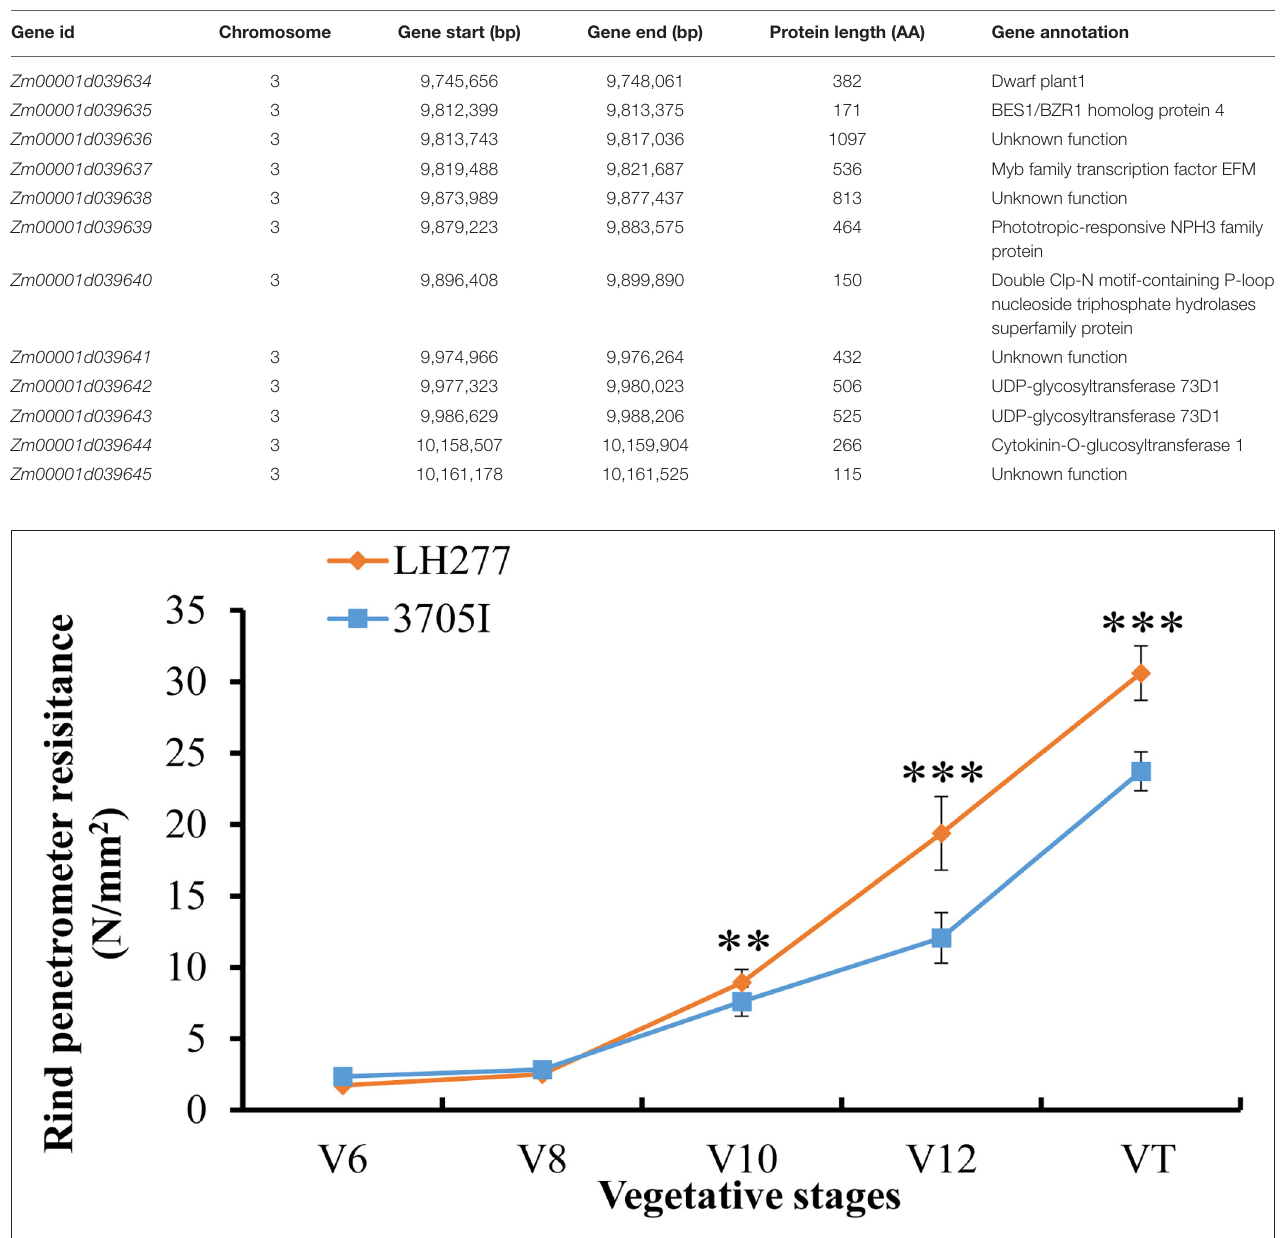
FIGURE 6 | Rind penetrometer resistance of 3705I and LH277 in V6, V8, V10, V12, and VT stages. V6, V8, V10, and V12 represent the last leaf stages, which were defined according to the uppermost leaf whose collar is visible, and VT (tasseling) was the last vegetative stage. **Significant at p < 0.01, ***Significant at p <